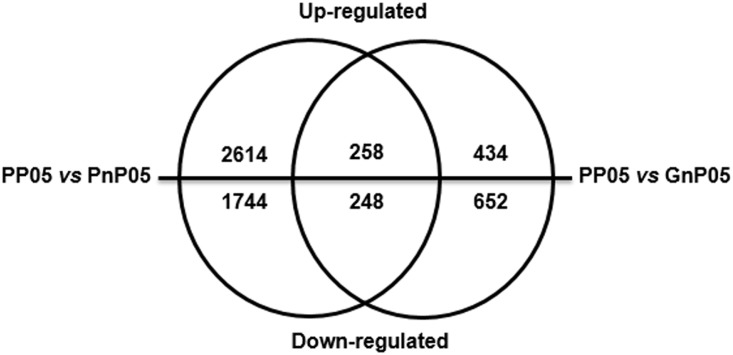
Venn diagram depicting the numbers of DEGs found in these three eggplant lines.